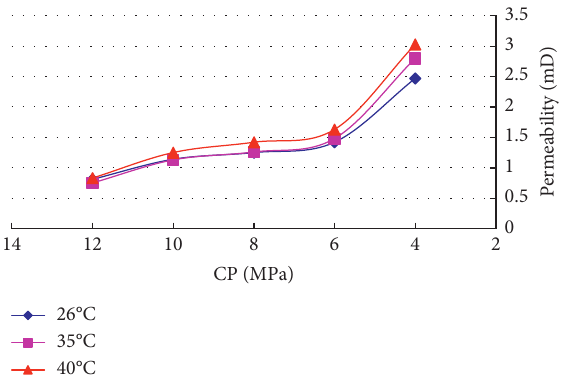
Figure 7: Variation in permeability during confining pressure unloading at a gas pressure of 1MPa.